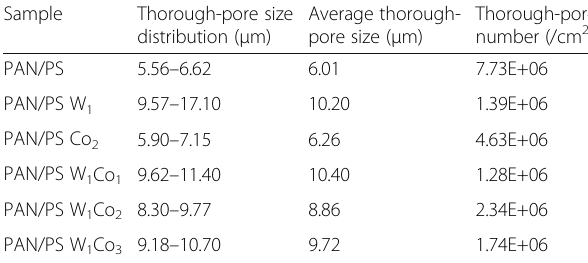
Table 1 The detailed data of through-pore size distribution